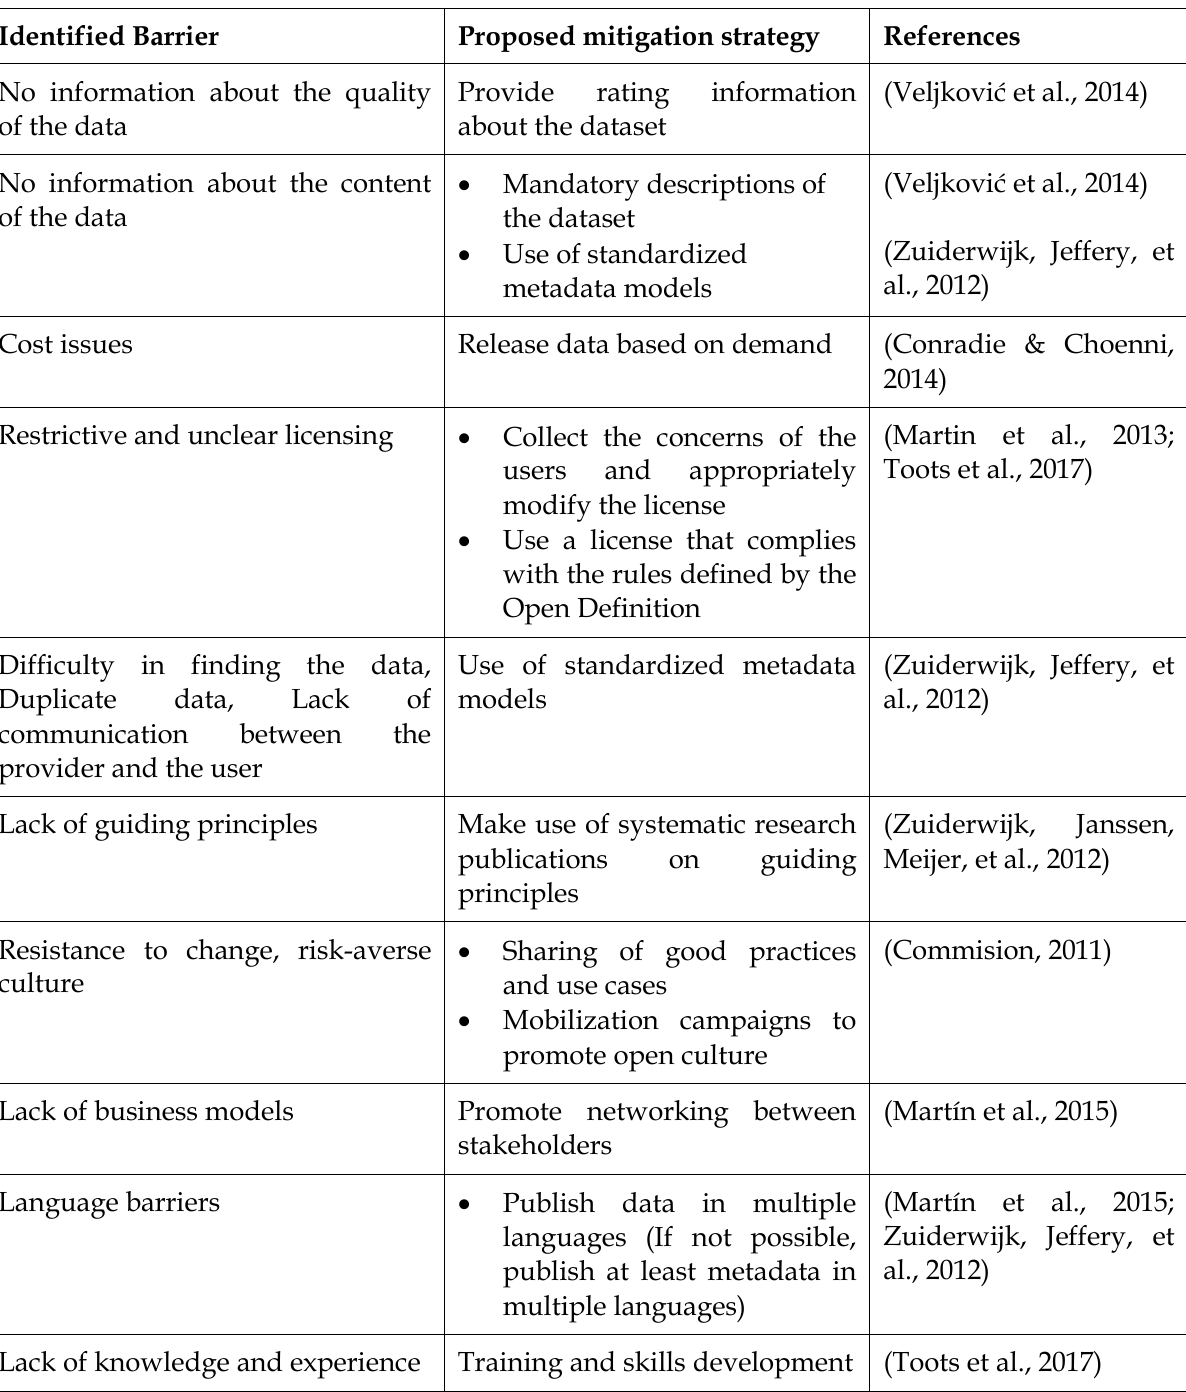
Table 9: Barrier Mitigation Strategies (Source: Authors) Identified